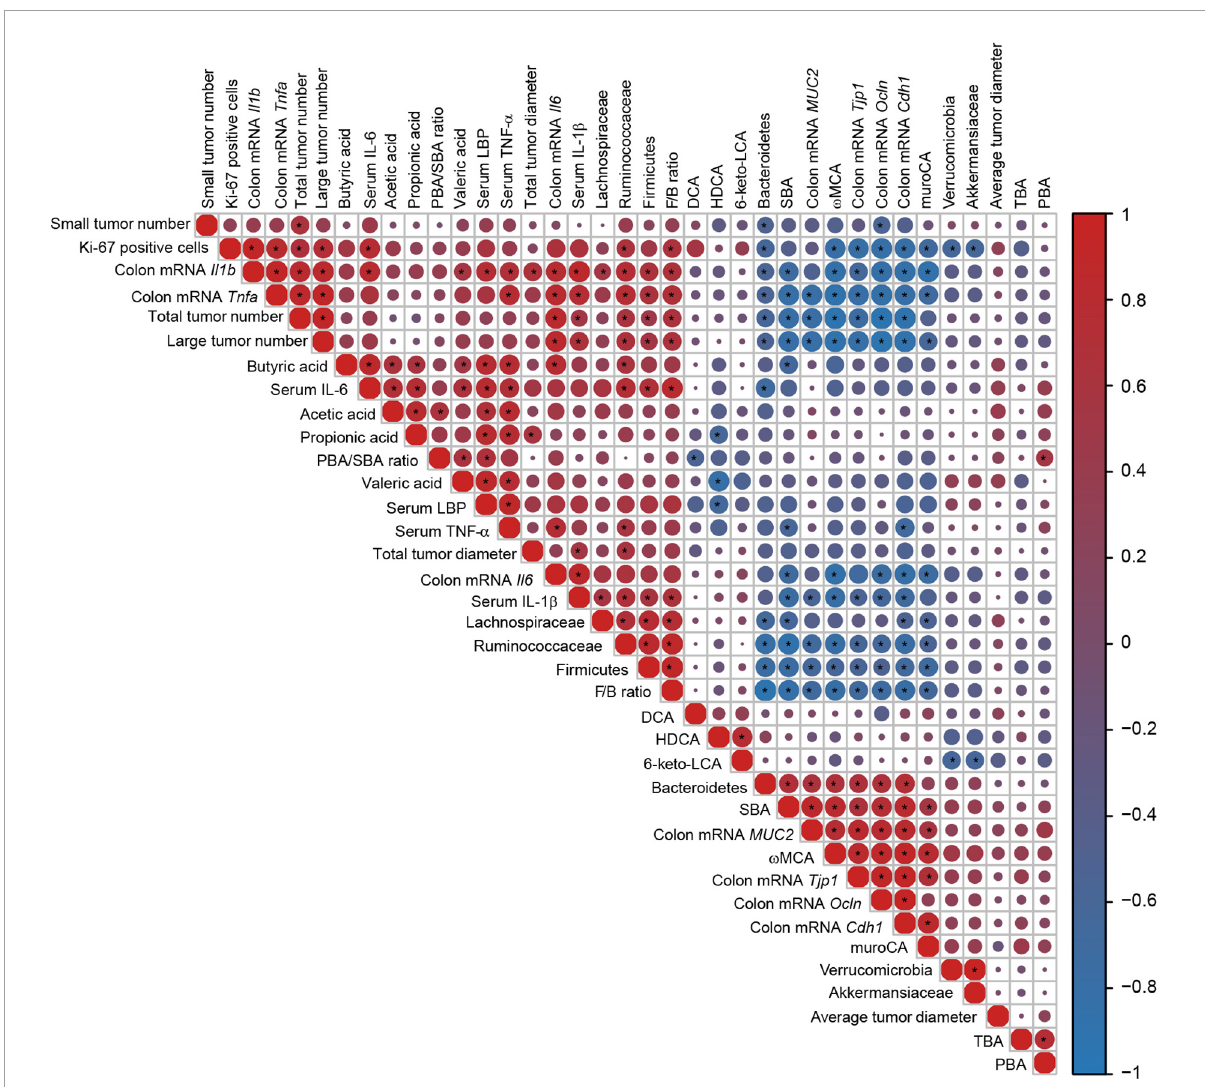
FIGURE9 Correlations heatmap of the tumor formation indicators, intestinal barrier indexes, inflammatory cytokines, microbes, and metabolites. Color scale and circle size indicate the correlation degree, red indicates a positive correlation, and blue indicates a negative correlation. Asterisk indicates significance. * P <